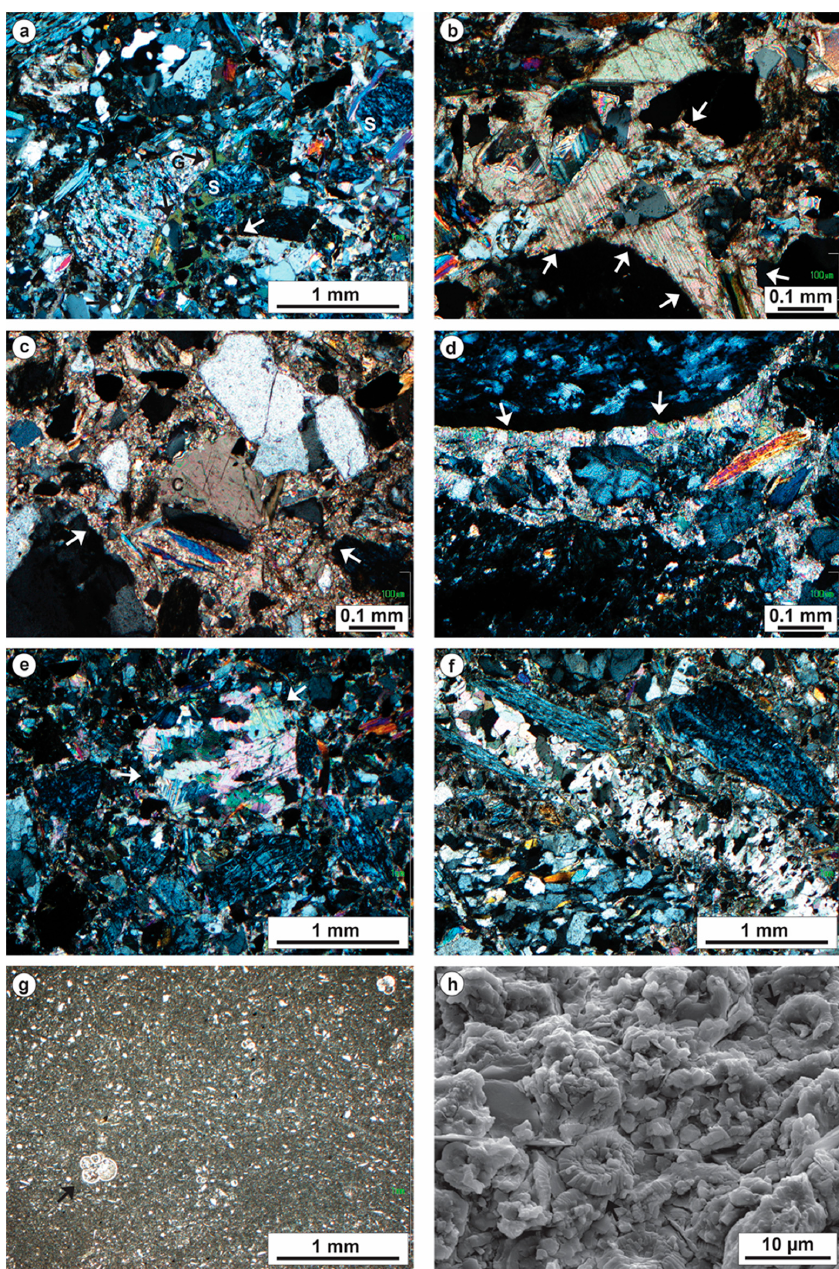
Figure 11. ( a ) Crossed polarizers photomicrograph of concretions with poikilotopic calcite cement (large crystal embedding several detrital grains, black arrows), gneiss rock fragments (G), muscovite, serpentinite (S) and planktonic foraminifer (white arrow); ( b ) close-up view of poikilotopic calcite cement (white arrows) embedding various detrital grains including quartz, feldspar and crystalline carbonate; ( c ) blocky sparite to microsparite cement (white arrows) probably related to carbonate matrix recrystallization embedding quartz, muscovite and crystalline carbonate rock fragments, probably marble (C); ( d ) blocky equant sparite cement lining serpentinite fragments (white arrows) and filling the interparticle space; e) detrital grain replaced by a mosaic of equant calcite (white arrows) in concretions; ( f ) Concretion with serpentinite and orthogneiss rock fragments cut by a fracture filled by prismatic and equant sparite; ( g ) Wackestone / mudstone clast deriving from the hemipelagites below CdV with planktonic foraminifers (black arrow); ( h ) SEM image of the hemipelagic marlstones below CdV showing calcareous nannoplankton coccoliths (black